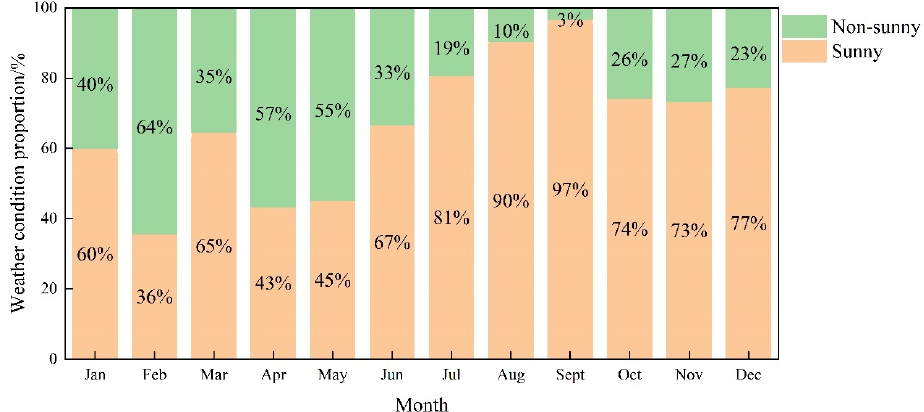
Figure 8. Spectral stability analysis of the Kufra, Libya site in different observation periods.